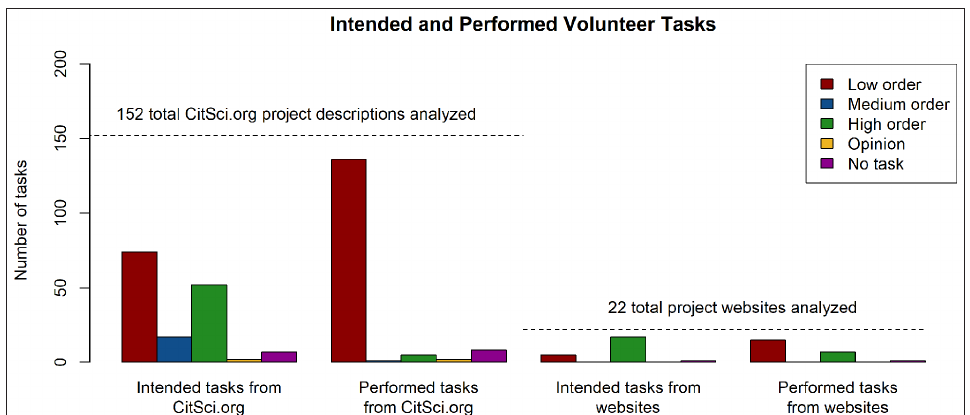
Figure 2: Intended and performed volunteer tasks. Presented according to cognitive level (low-, medium-, and high- order tasks), the solicitation of an opinion, or no task expectations.